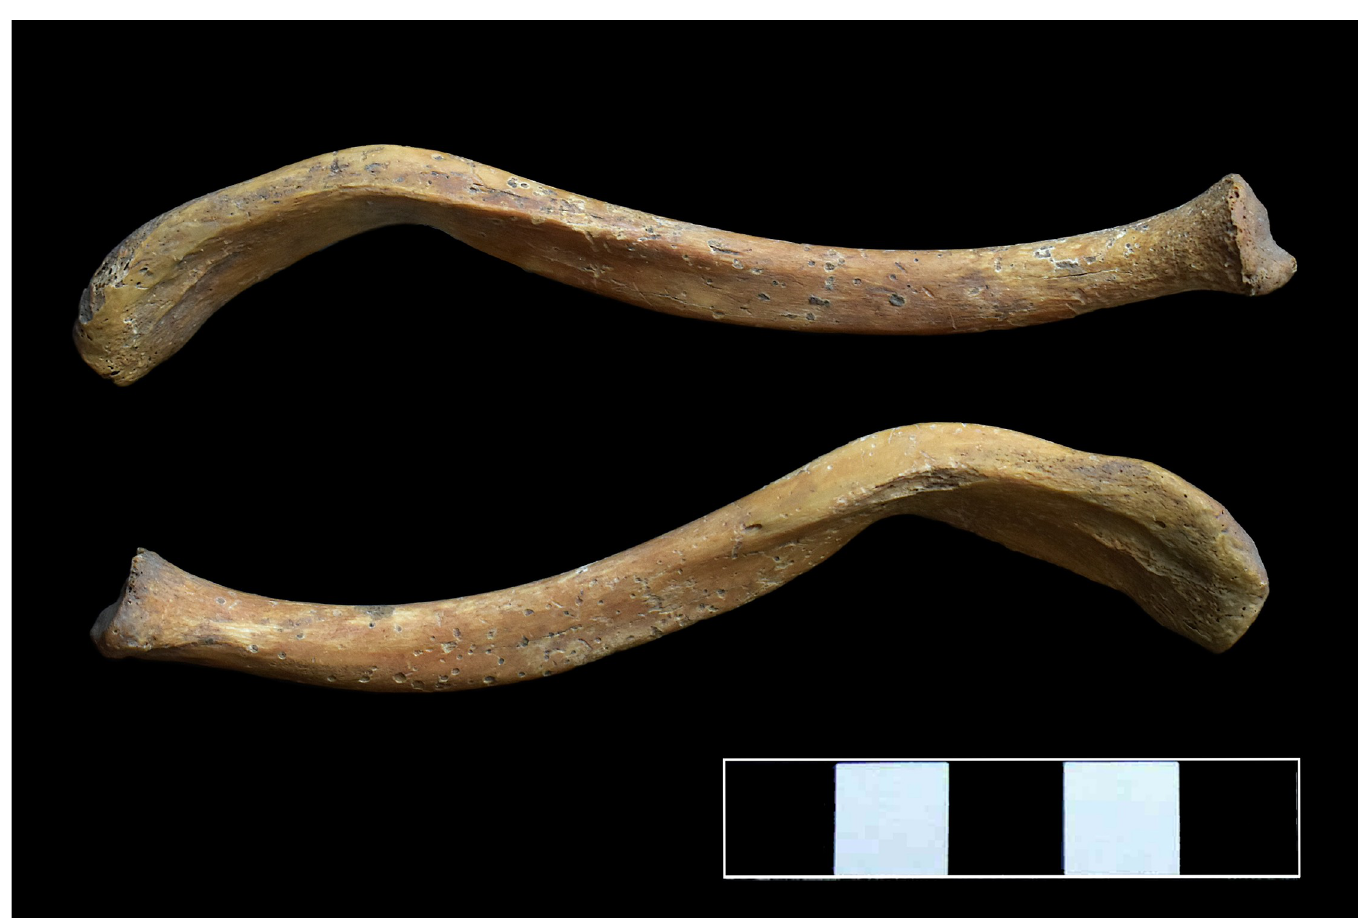
Fig 11. Abnormal curvature of the clavicles. [58, 63, 67]. Although the extra-vertebral cold abscess can remain localized at the initial site of infection, in most cases, it extends vertically (usually downwards) beneath the anterior longitu- dinal ligament or along the fascial planes [63, 67]. In response to an overlying cold abscess, erosive cortical bone destruction and/or reactive new bone formation can occur on the adja- cent bone surfaces (e.g., vertebrae, hip bones, and femora) [63]. can result in their consequent collapse under the weight of the trunk [23, 62]. This is character- portion of the vertebral body, with intact or less destroyed posterior vertebral elements [62, may lead to the development of different spinal deformities, most frequently of a sharp angular kyphosis in the thoracic spine (i.e., Pott’s gibbus) [57, 60, 63, 67]. The progressive bone destruction and consequent deformity can result in mechanical instability of the spine [59, 60, 66, 67]. To stabilize the vertebral column, subsequent bony fusion of the remnants of the col- lapsed vertebral bodies and posterior vertebral elements, bony ankylosis of the intervertebral joints, ossification of the intervertebral ligaments, and formation of bony extensions intercon- necting the adjacent vertebrae can occur [59, 63].